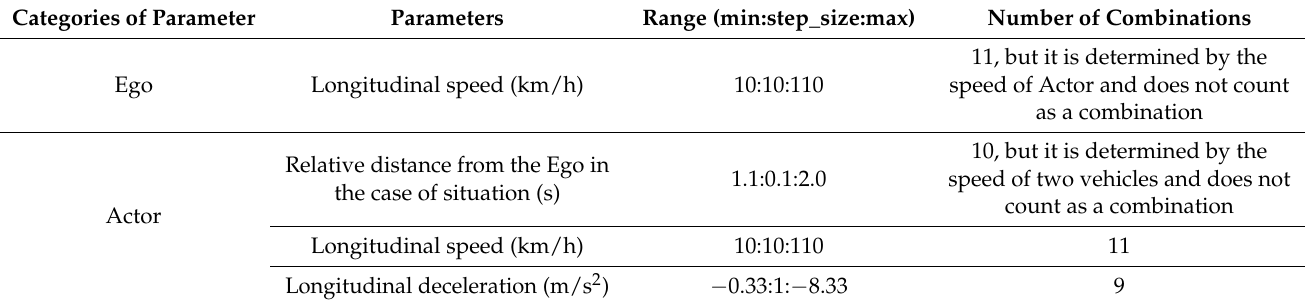
Table 4. Concrete scenario generation